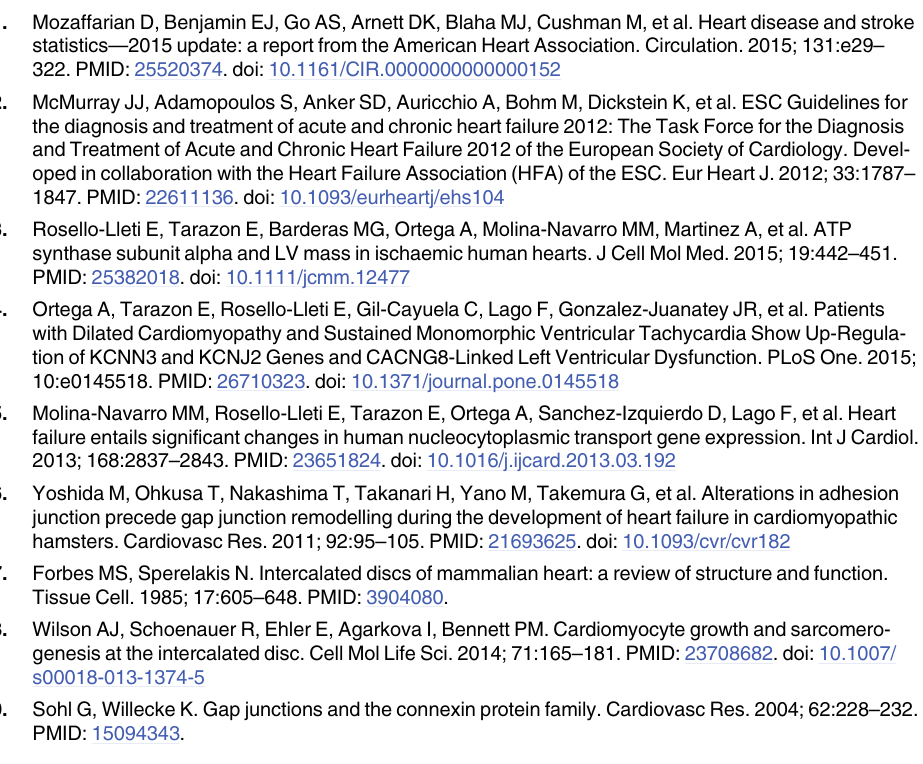
S1 Table. Relationships between differentially expressed cell adhesion genes in ICM patients. S2 Table. Relationships between differentially expressed cell adhesion genes and hemody- namic and LV function parameters of ICM